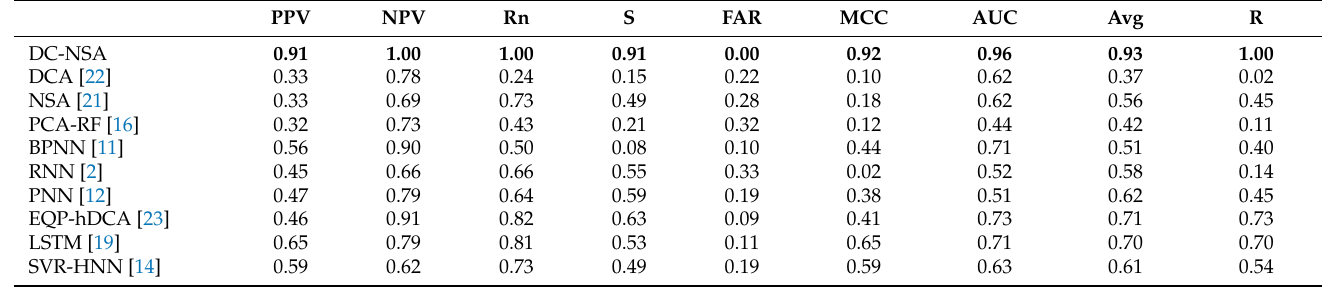
Table 7. Comparison between DC-NSA and other approaches when predicting DS3. The best results are in bold.